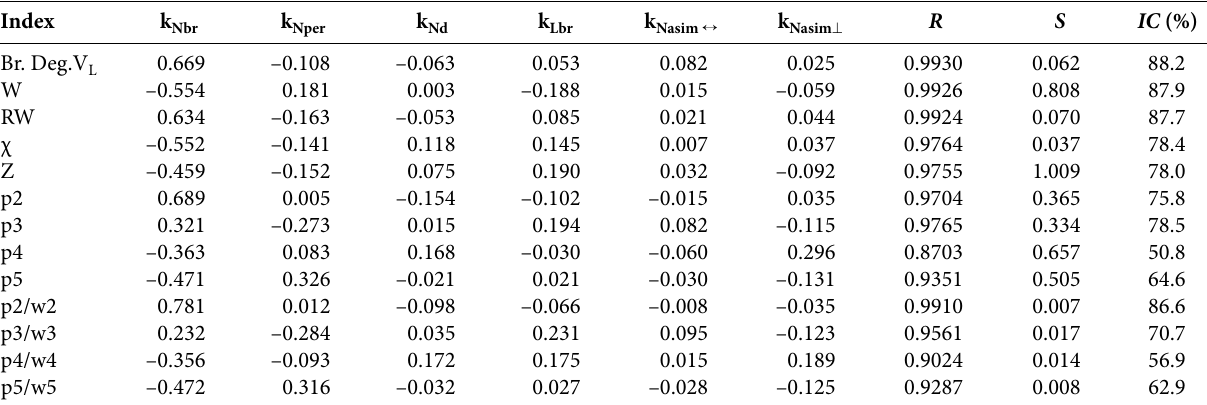
Table 4. Results of optimization of the correlation between the MOC SN and the values of some topological indices of octanes. The values of topological indices of octanes were taken from Ref.